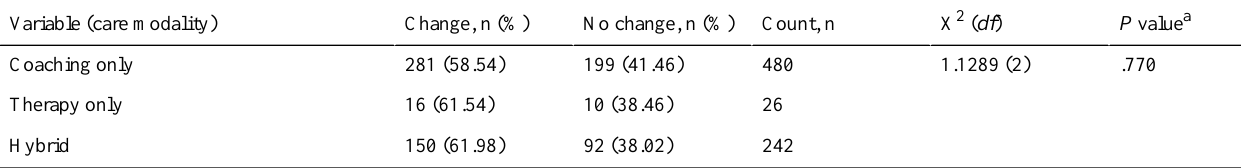
Table 3. Association between PHQ-2 improvements and care modality